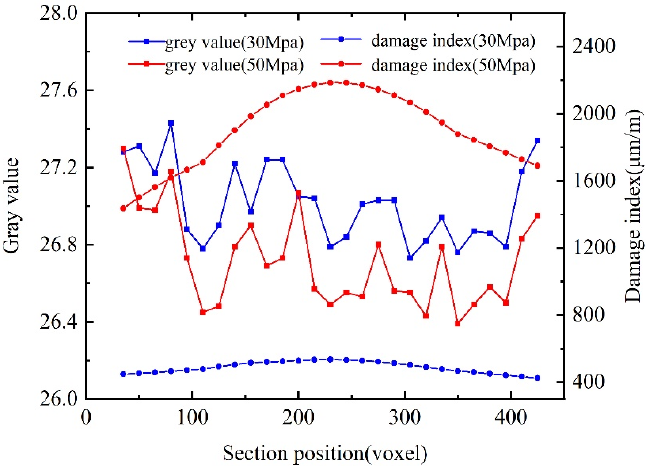
Figure 15. Gray value and damage index of di ff erent section position.